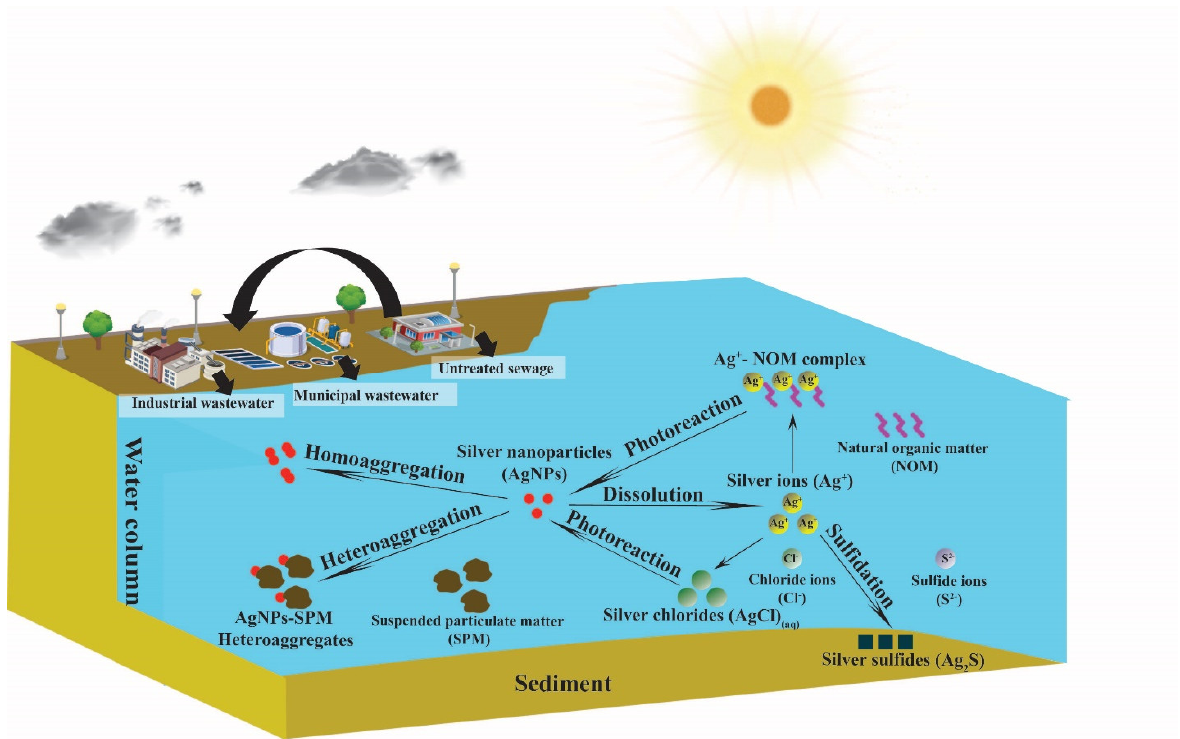
Figure 1. Engineered nanomaterial (ENM) fate processes in surface waters.